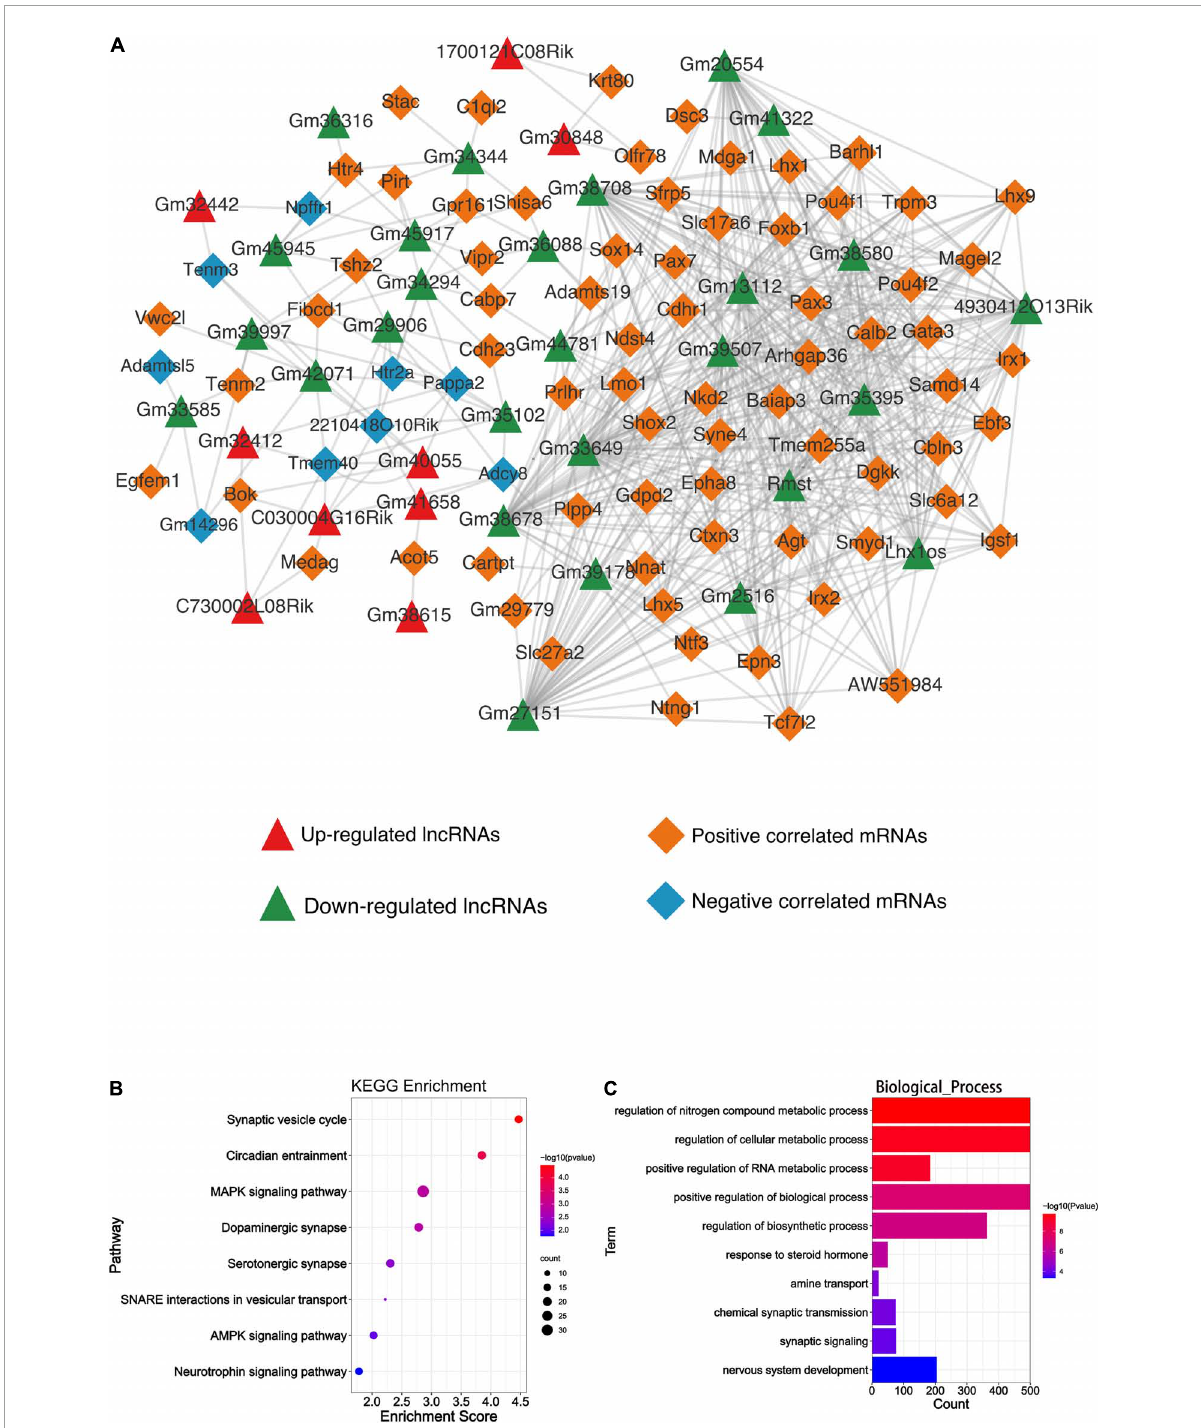
FIGURE6 Bioinformatics analysis results of the DElncRNAs and DEmiRNAs. (A) The lncRNA-mRNA co-expression network. Green and red triangles represent the down-regulated and up-regulated DElncRNAs, respectively. Orange and blue diamonds represent the positive and negative correlated mRNAs, respectively. (B) The KEGG enrichment analysis of the predicted genes of DEmiRNAs. The abscissa enrichment score represents the enriched extent of the pathway and the ordinate represents each pathway. The size of the dots represents the number of genes in each pathway, the color of the dots represents the -log10 ( p -value), and p -value was corrected by FDR. (C) The GO_BP enrichment analysis of the predicted genes of DEmiRNAs. The abscissa represents the count in the GO_BP term, the ordinate represents the GO_BP term, and the color of the column represents the -log10 ( p